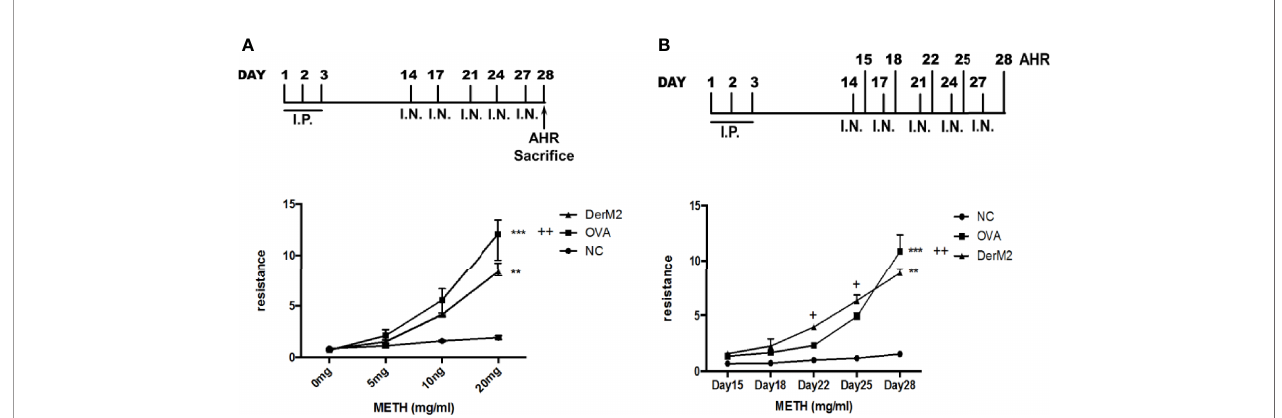
FIGURE 5 | The effect of recombinant Der m 2 protein on female BALB/c mice. (A) The upper panel is the mouse sensitization diagrammatic schedule. The mice were intraperitoneally injected with allergen or not in the fi rst 3 days and were administered intranasal allergens at days 14, 17, 21, 24, and 27; total of 5 days. After the airway hyperactivity (AHR) determination, the mice were euthanized at day 28. The lower panel is the mouse ’ s AHR to methacholine (METH) assessed with the Buxco system. Normal group (NC) was shown as ● , Der m 2 sensitization group was shown as ▲ , ovalbumin (OVA) sensitization group was shown as ■ . (B) The upper panel is the mouse sensitization diagrammatic schedule. The mice were treated as aforementioned but measured the AHR at days 15, 18, 22, 25, and 28. Normal group (NC) was shown as ● , Der m 2 sensitization group was shown as ▲ , OVA sensitization group was shown as ■ . *** P < 0.001 and ** P < 0.01 compared with NC; ++ P < 0.01 and + P < 0.05 compared with